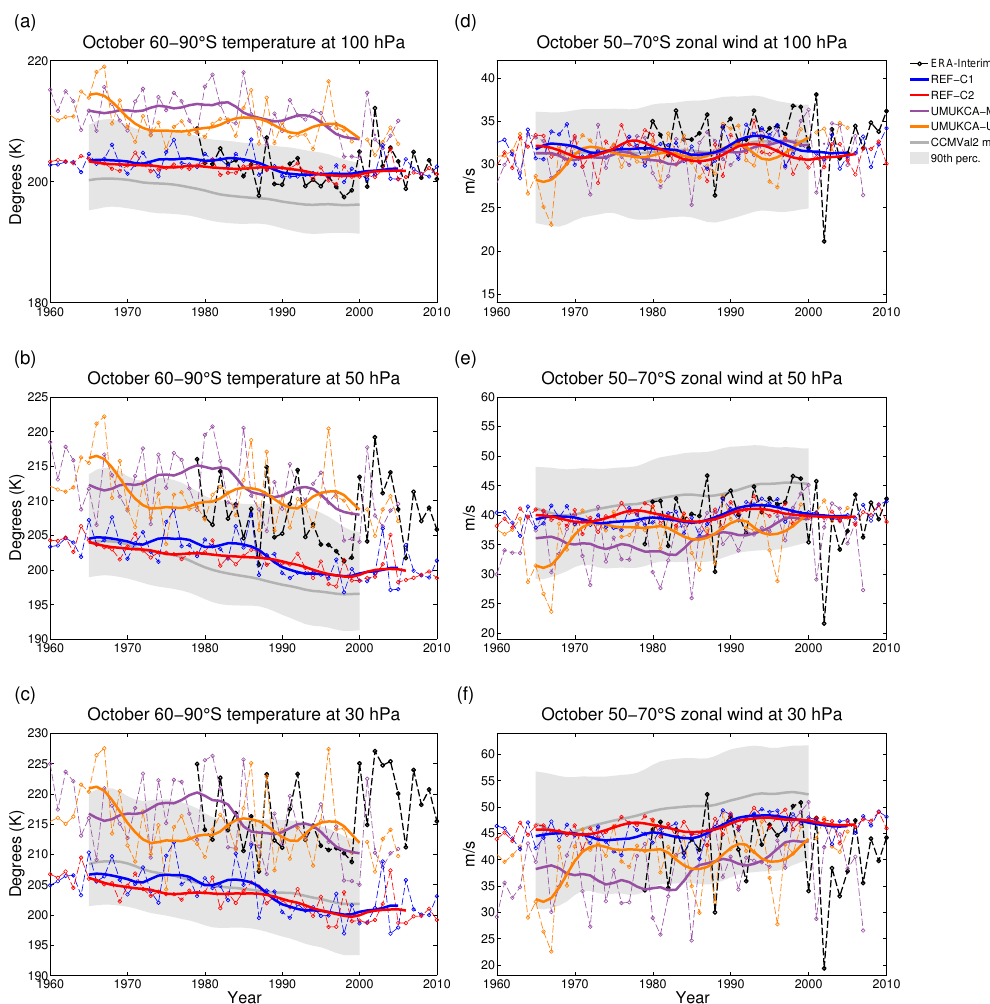
Figure 3. Time series of REF-C1 and REF-C2 temperature at (a) 100hPa, (b) 50hPa and (c) 30hPa averaged between 60 and 90 ◦ S and zonal wind at (d) 100hPa, (e) 50hPa and (f) 30hPa averaged between 50 and 70 ◦ S compared with ERA-Interim, the UMUKCA-UCAM and UMUKCA-METO models and the CCMVal-2 ensemble. The shaded region shows 10th and 90th percentiles of the CCMVal-2 ensemble.